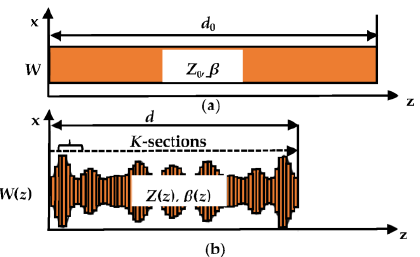
Figure 1. Future project: compact reconfigurable 5G and UWB antenna.